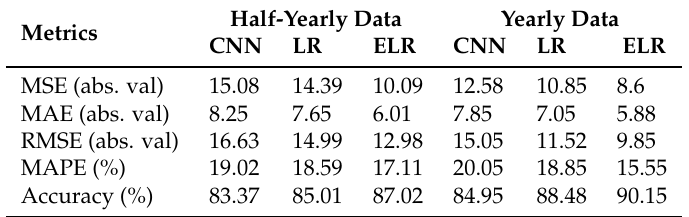
Table 16. Price performance metrics comparison for one day using the UMass Electric Dataset.